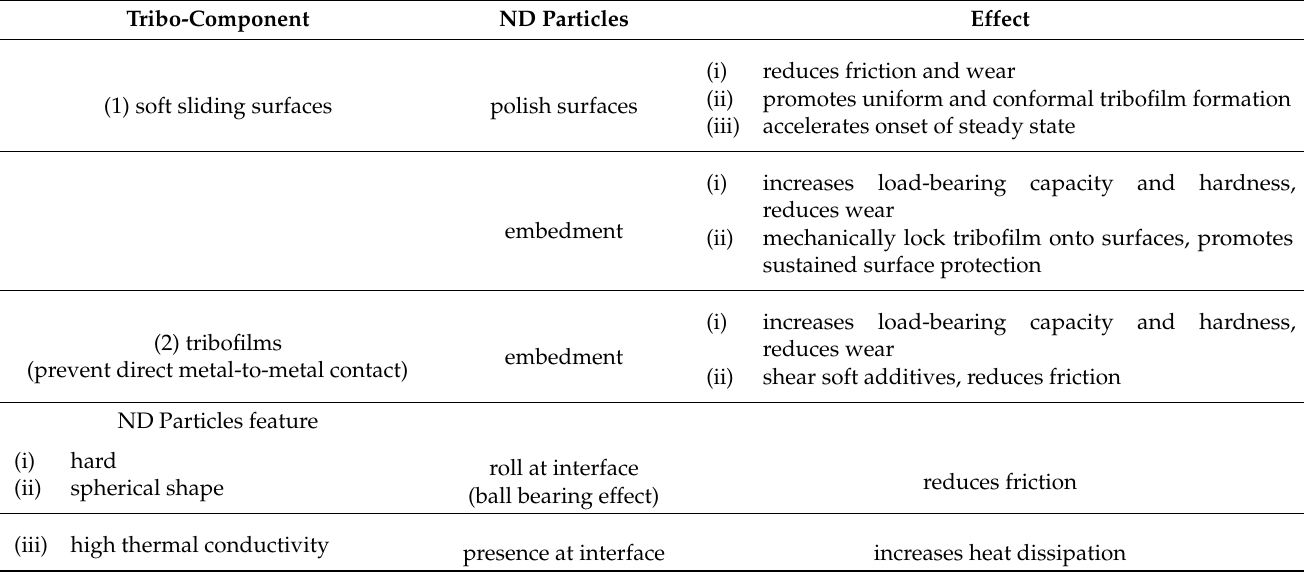
Table 7. Nanodiamond (ND) particles’ interaction with